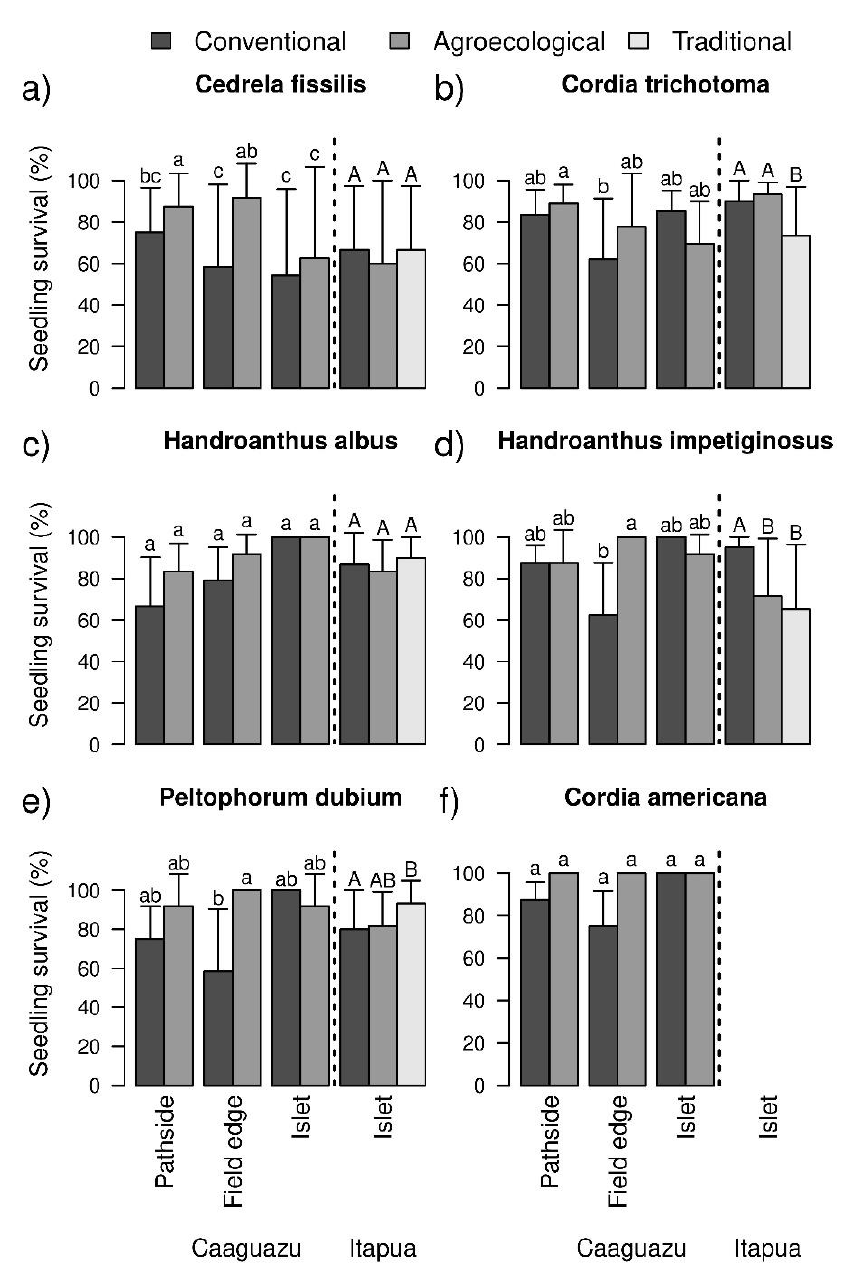
Figure 2. Survival of the planted species in different agronomic systems and plantation types. The time interval in Caaguazú and in Itapúa was from 2010 to 2016 and from 2012 to 2016, respectively. The subfigures ( a – f ) are the species. The letters “a”, “b”, “c”, “ab”, “bc”, “A”, “B” and “AB”, are statistical differences and similarities between agricultural systems.